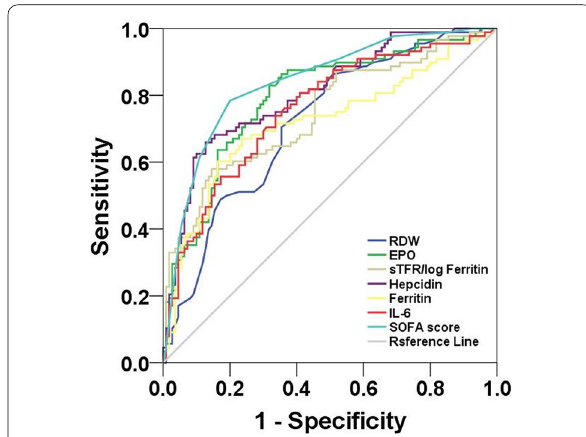
Fig. 2 Receiver operating characteristic curves of inflammatory anemia‑associated parameters and the SOFA score for predicting 28‑day mortality. EPO, erythropoietin; IL‑6, interleukin‑6; RDW, red blood cell distribution width; SOFA, Sequential Organ Failure Assessment; sTfR, soluble transferrin receptor. The AUCs of plasma EPO (0.794), ferritin (0.720), IL‑6 (0.757), sTfR/log ferritin (0.747) and the RDW (0.718) were lower than the SOFA score (0.840) (all P < 0.05), but plasma hepcidin (0.808) had an AUC similar to the SOFA score ( P =